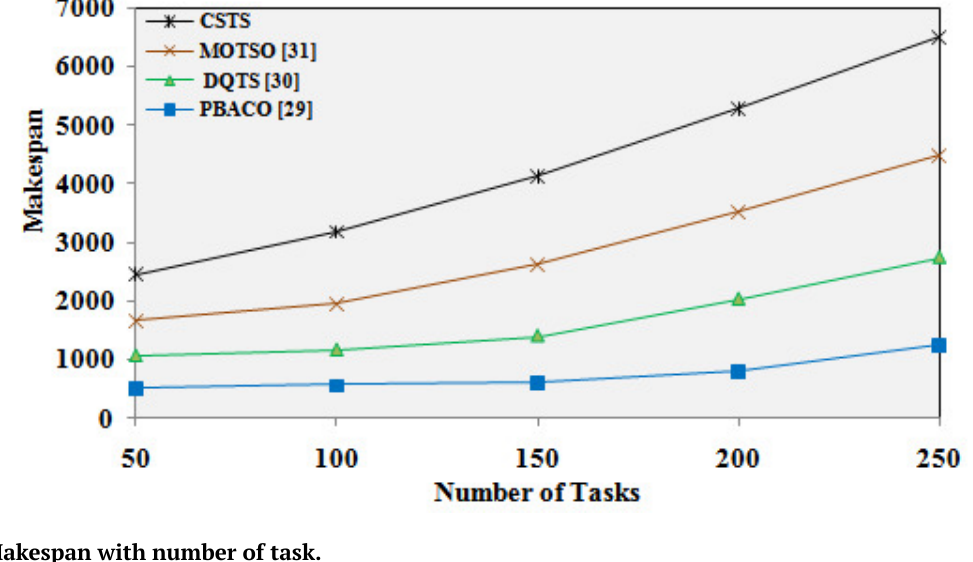
Figure 2. Makespan with number of task.